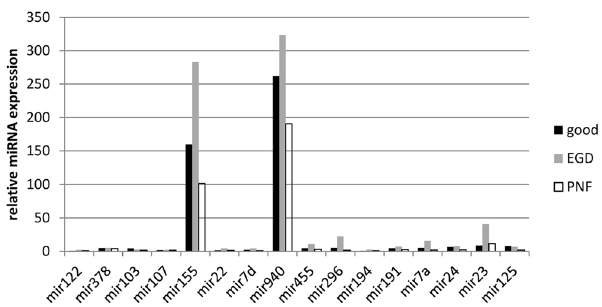
Fig 3. Real time quantitative PCR profile in donation after cardiac death liver. From the microRNA (miRNA) array analysis 16 miRNAs were identified as having significant differential expression (p < 0.05) and selected for validation with real time quantitative PCR (RT-qPCR). Threshold cycle (Ct) values were normalised using the average Ct of small nucleolar RNAs (snoRNAs) and to determine miRNA relative expression 2 ΔΔ CT was used and calculated as follows Δ CT (miRNA Ct — averaged endogenous control Ct) and fold-change to reference sample of normal liver (a non steatotic donation after brain stem death liver). Across the three donation after cardiac death (DCD) liver groups of primary non function (PNF) retransplanted within a week (n = 7), good functional outcome (n = 7) peak aspartate transaminase (AST) (cid:1) 1000 IU/L and early graft dysfunction (EGD) (n = 9) peak AST (cid:3) 2500 IU/L, miR-155 and miR-940 had the highest relative